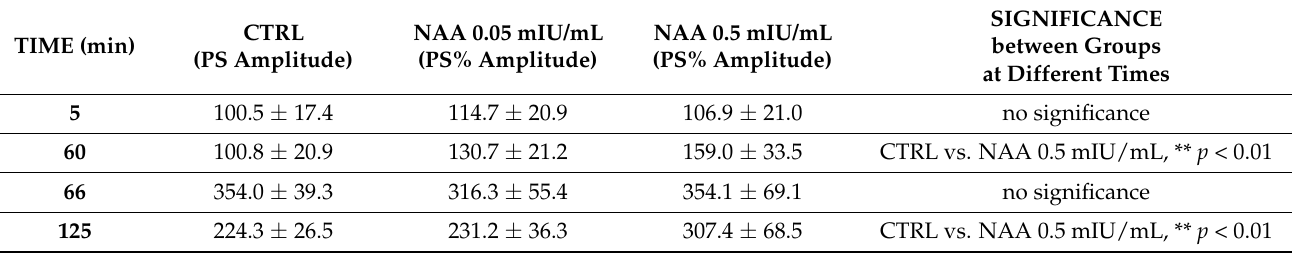
Table 2. Percentage of PS amplitude values of BST and LTP recorded in the CA1 region of hippocampal slices from the control group and groups treated with two different concentrations of NAA at different times.